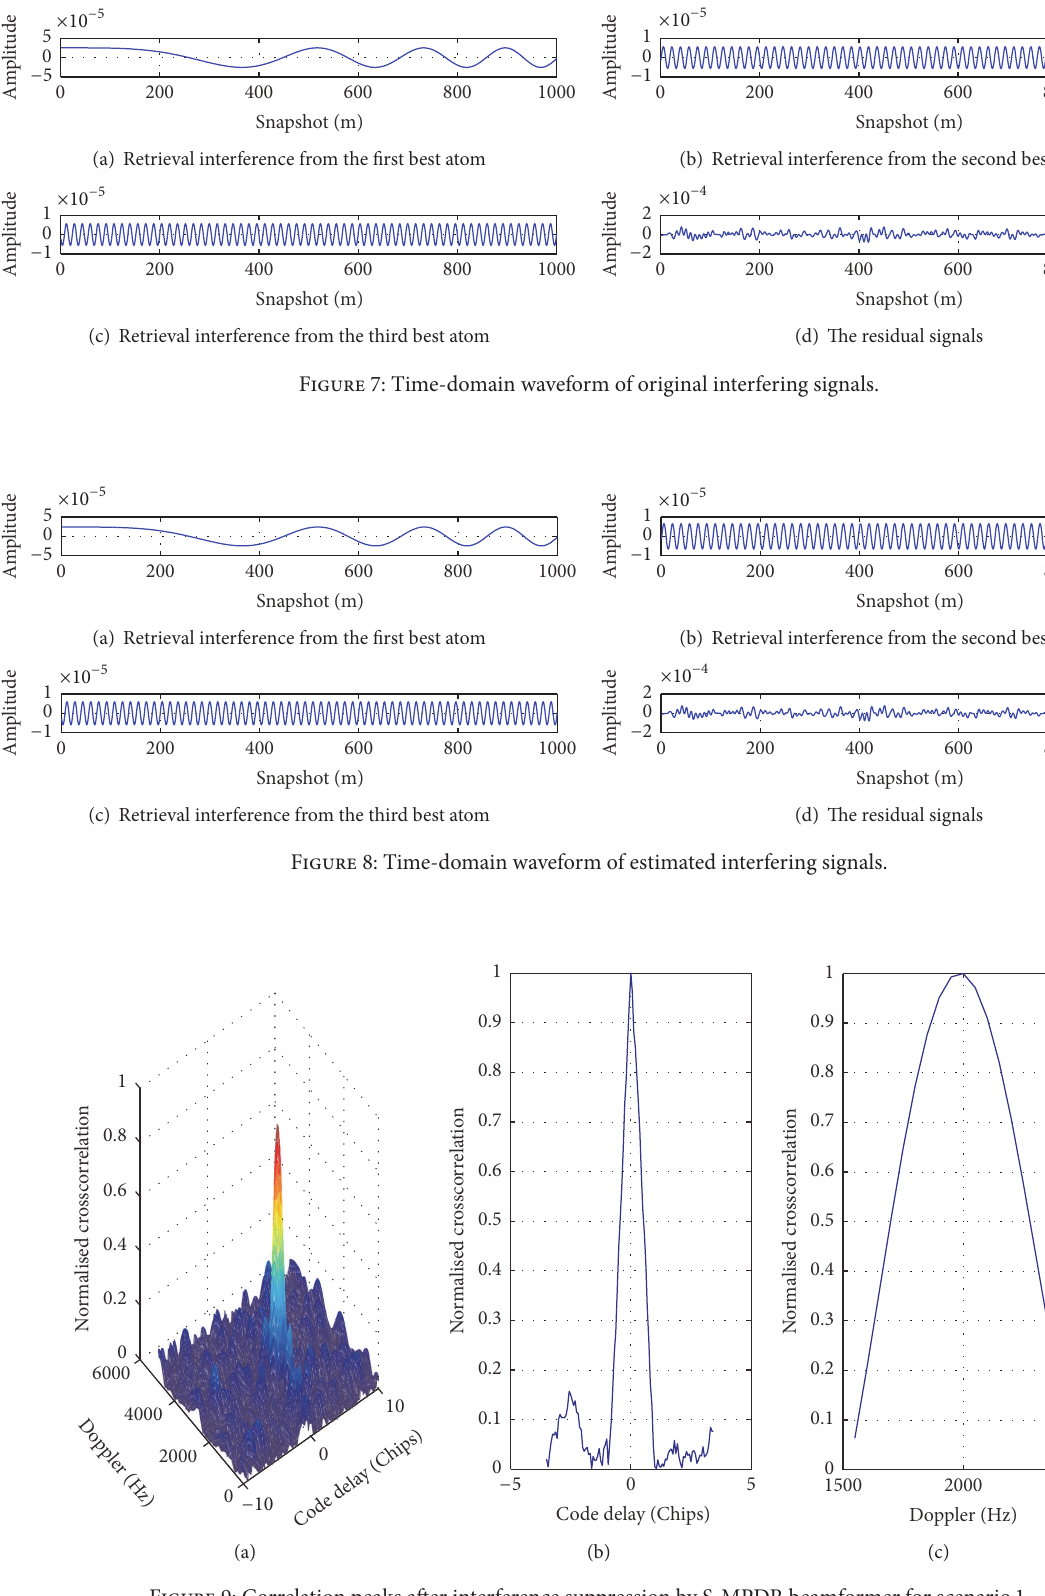
Figure 9: Correlation peaks after interference suppression by S-MPDR beamformer for scenario